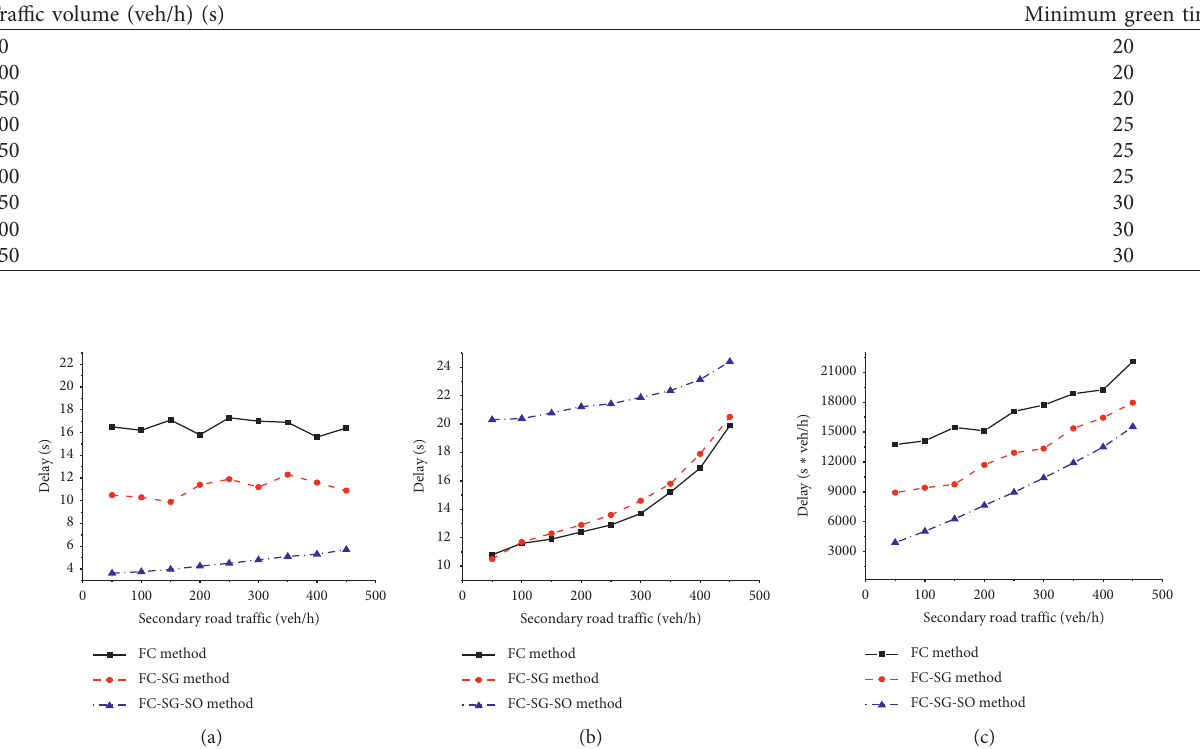
Figure 7: Delays under different traffic volumes of secondary roads. (a) Main road delay. (b) Secondary road delay. (c) Total